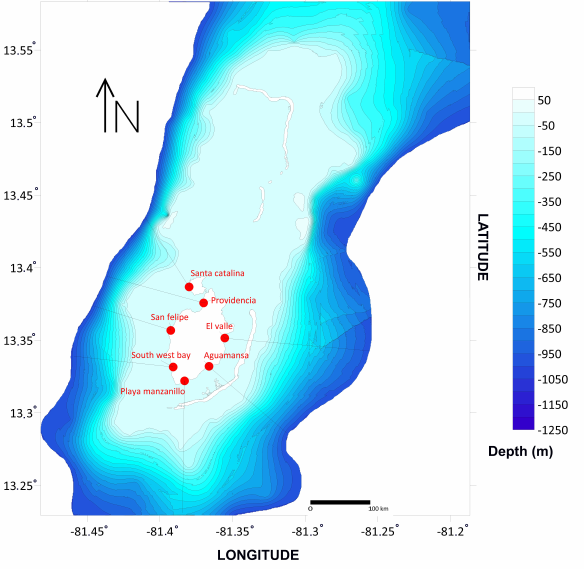
Figure 10. Bathymetry of Providencia and Santa Catalina. ( a ) Western. ( b ) Eastern.